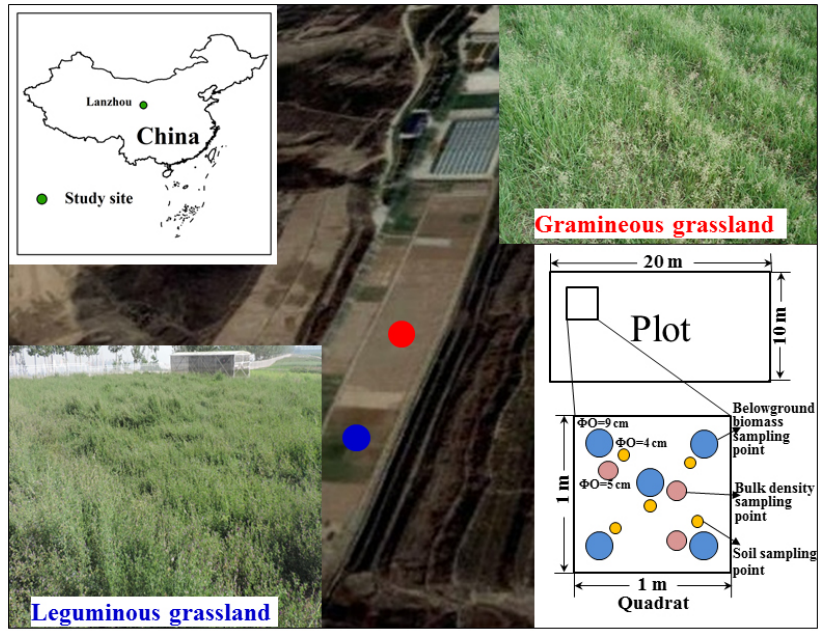
Figure 1. The studied site localization and schematic figure of the sampling strategies. Table 1. Description of studied grassland types. Grassland types Species Leguminous grassland Coronilla varia